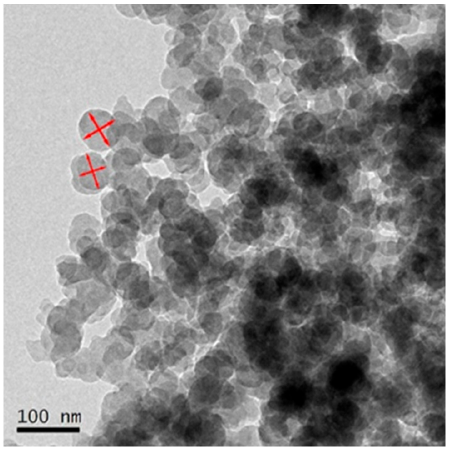
Figure 3. “Cross method” measurement method.